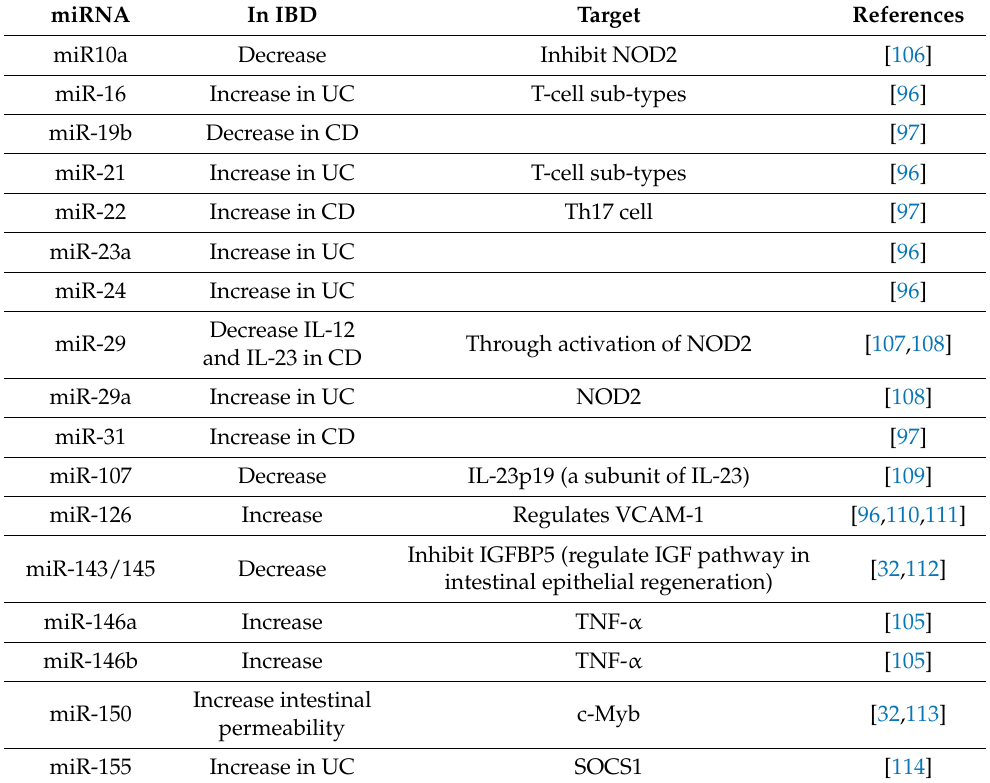
Table 2. The main microRNA involved in Inflammatory Bowel Disease patients.